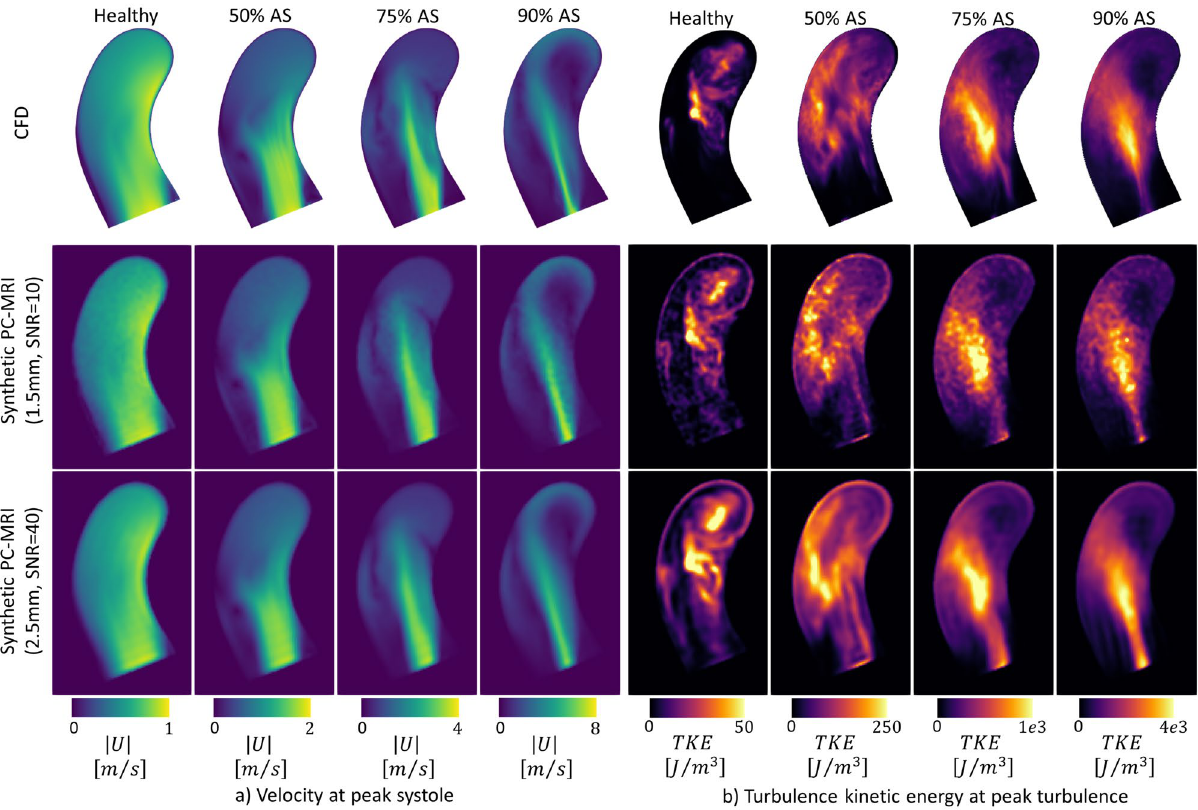
Figure 5. Patient-specific velocity and TKE maps for varying degrees of stenosis (foot-head slices of the aorta aligned with the inflow jet). ( a ) Magnitude of the velocity at peak systole and ( b ) turbulent kinetic energy at peak total TKE for two resolutions and the corresponding reference CFD. For ( a ) and ( b ), from left to right, healthy inlet flow and simulated stenosis degrees of 50%, 75% and 90% are shown. Note the difference in color bar scaling for both velocity and TKE depending on the stenosis degree. A video showing all time steps is available in the online supplemental